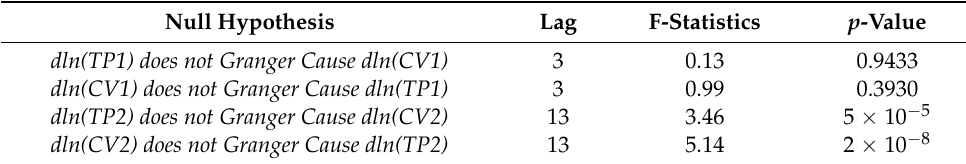
Table 4. Result of Granger causality tests.